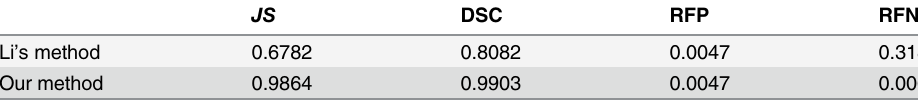
Table 1. JS, DSC, RFP and RFN values for the results in the second row of Fig. 2 and Fig. 4.